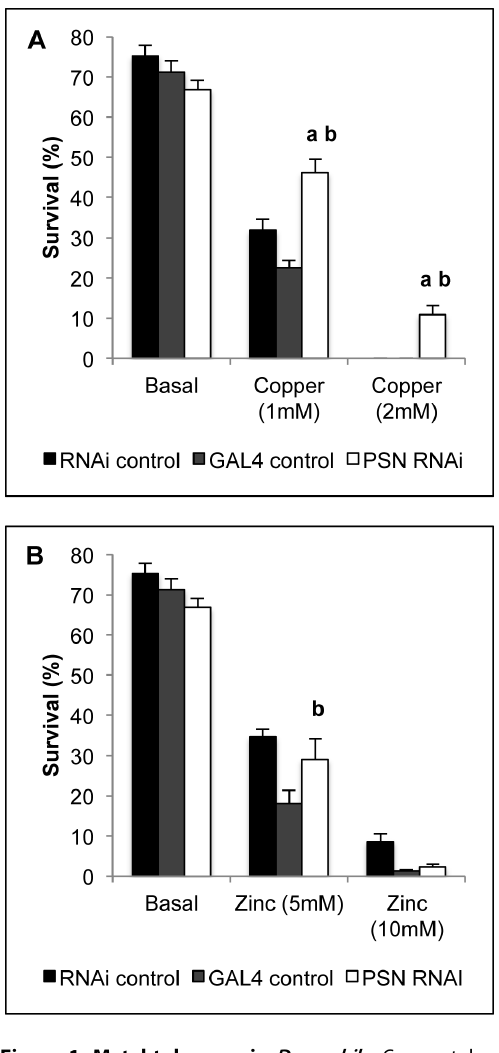
Figure 1. Metal tolerance in Drosophila . Copper tolerance (A) and zinc tolerance (B) were assessed by survival to adulthood on basal media and metal-supplemented media for control (RNAi control, GAL4 control) and midgut PSN knockdown ( PSN RNAi) Drosophila . Values are percentage survival with S.E.M. from fifteen replicates of 50 Drosophila . PSN knockdown Drosophila were highly tolerant to copper-supple- mented media. a Significant difference from RNAi control, b significant difference from GAL4 control, as determined by two-way ANOVA with Tukey’s post-hoc test (P , 0.05).